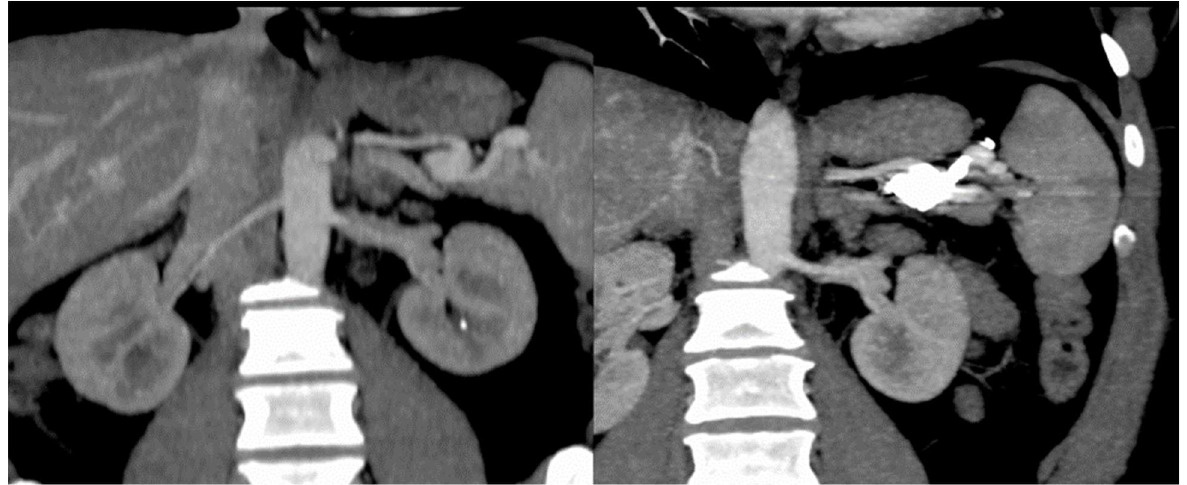
Figure 1. Embolization of splenic artery aneurysm in HHT patient.